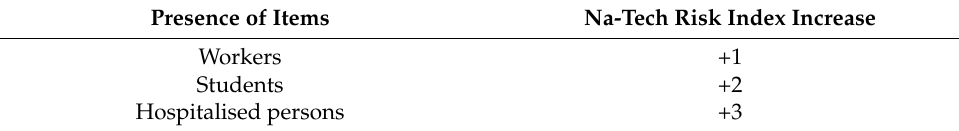
Table 2. Criterion for the increase of the index for the Na-Tech risk node.